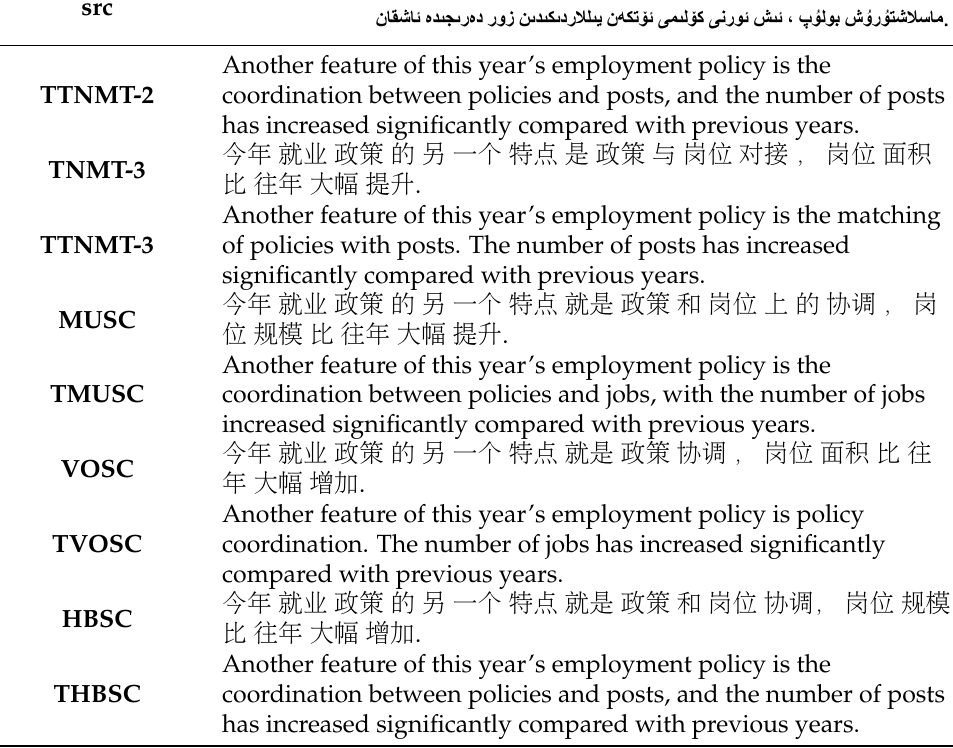
Table 10. Translation examples of single systems and our proposed hybrid framework. Tsrc, TPBMT, THPMT, TRNMT, TTNMT, TTNMT-1, TTNMT-2, TTNMT-3 are English translations of the src , PBMT (phrase-based statistical machine translation (SMT)), HPMT (hierarchical phrase- based SMT), RNMT, TNMT (Transformer-based neural machine translation (NMT)), TNMT-1, Table 10. Cont. TNMT-2, TNMT-3,